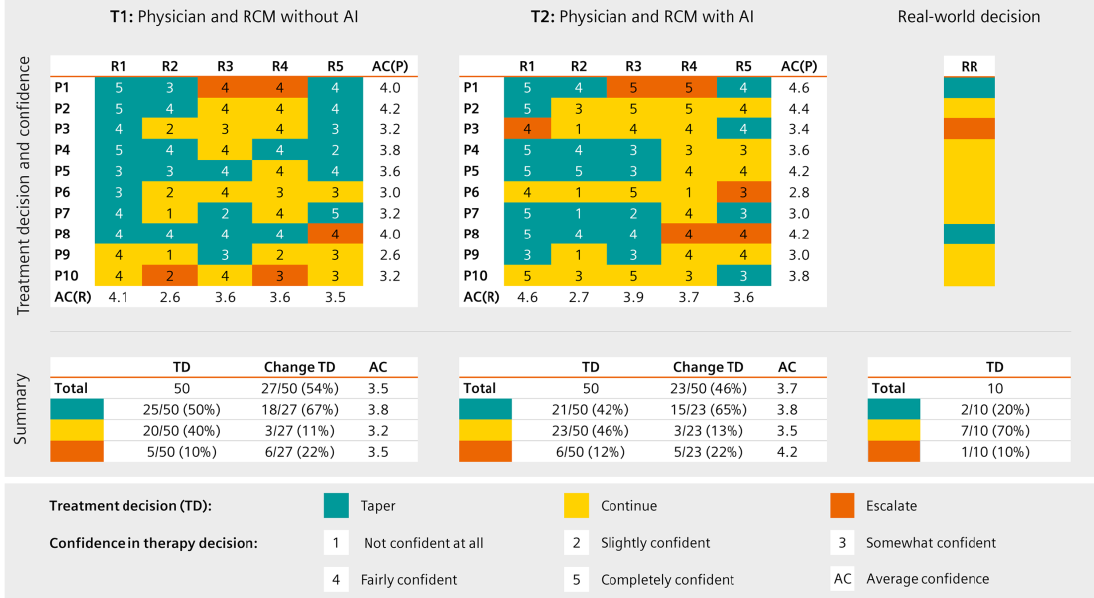
Figure 7. Treatment decisions of physicians (R1 – R5) for the ten patient vignettes (P1 – P10) according to the five physicians and the real-world treatment decision (RR). The type of decision is shown in different colours (tapering — petrol; no change — yellow; escalation — orange). Perceived confidence in treatment decision per patient and physician and average confidence are also displayed.